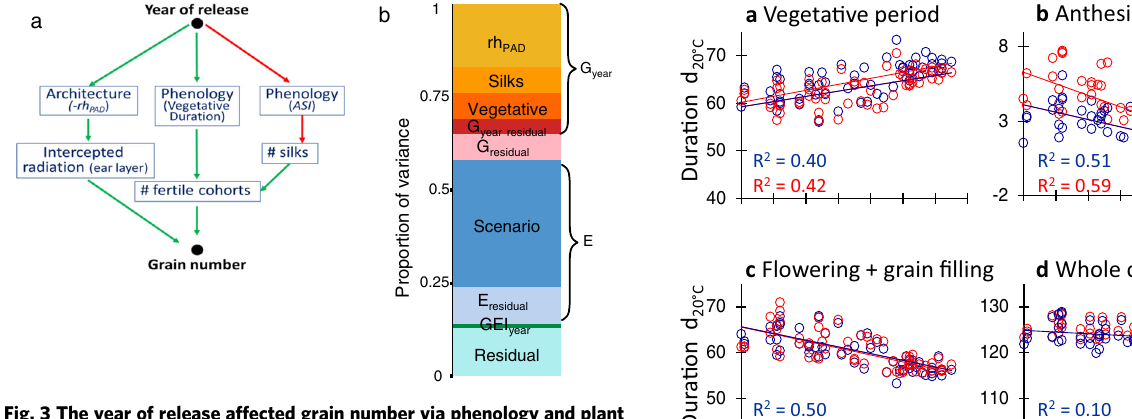
green rectangle represents the residual G × E and error. Source data in Supplementary data 3.